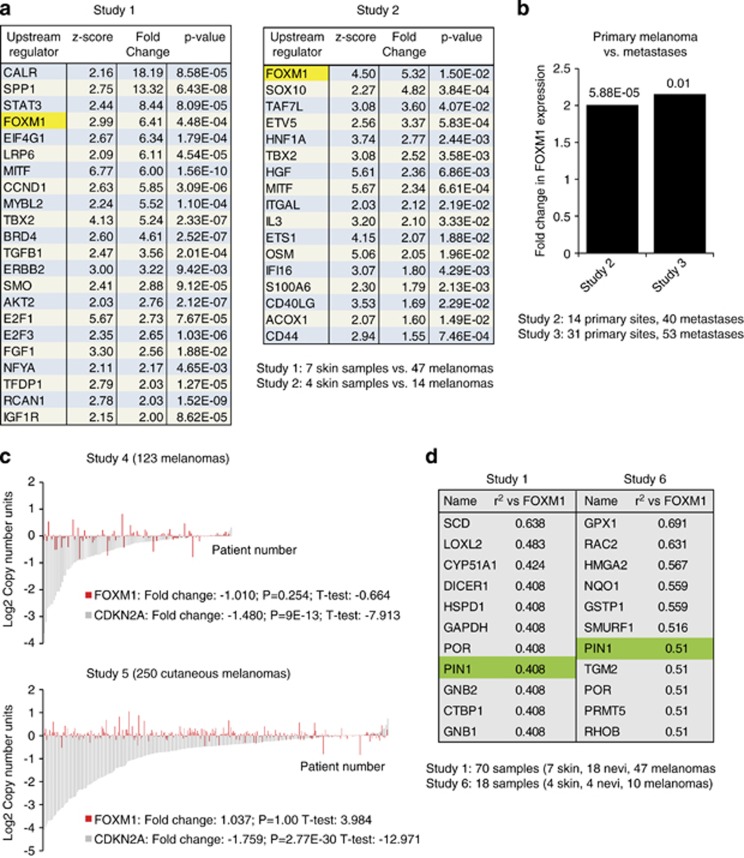
FOXM1 is elevated and activated in malignant melanoma. (a) Ingenuity Pathway Analysis (IPA; Version build 242990) for upstream regulators in data sets obtained from Oncomine.43, 44 Shown are those genes predicted to be activated based on upstream regulator analysis (z-score) and that are themselves upregulated at least 1.5-fold with a P-value <0.05. (b) Expression of FOXM1 mRNA in two independent Oncomine data sets,44, 45 comparing primary melanoma vs metastases. P-values are indicated. (c) Analysis of copy number variation of FOXM1 in two independent Oncomine data sets46 (and The Cancer Genome Atlas melanoma). CDKN2A is shown as a control and is known to show a reduction in copy number in many melanomas.15 (d) Co-expression analysis for genes correlating with FOXM1 in two independent Oncomine data sets,43, 47 showing the top candidates to co-express with FOXM1 in melanoma.